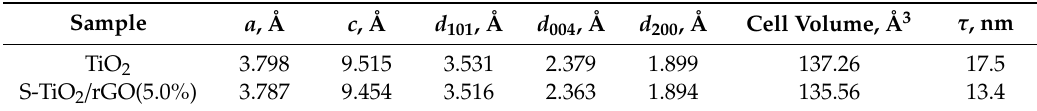
Figure 5. X-ray diffractograms (XRD) analysis of hydrothermally obtained TiO 2 and S- TiO 2 /rGO(5.0%). Calculated lattice parameters, cell volume, and crystallite sizes for TiO 2 and S-TiO 2 / rGO(5.0%) are provided in Table 1. Table 1. Comparison of lattice parameters, d-spacings, cell volumes, and crystallite sizes for TiO 2 and S-TiO 2 /rGO (5.0%)